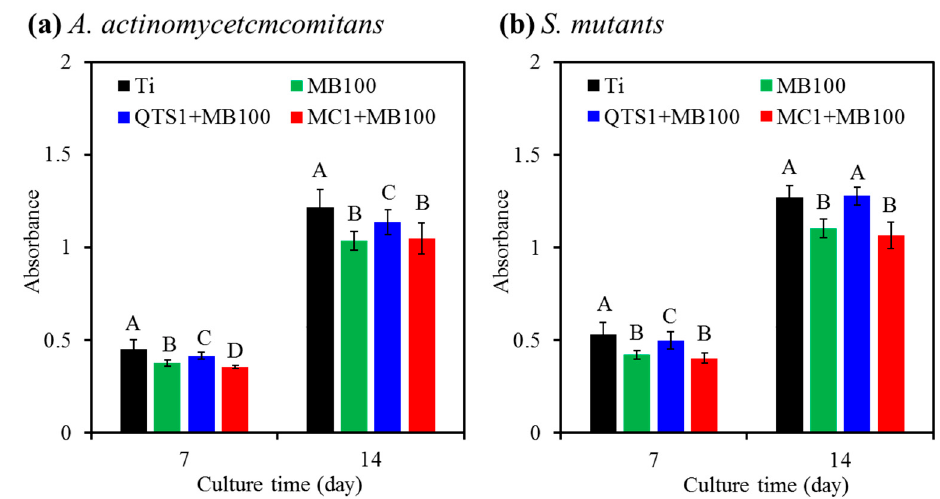
Figure 10. ALP activity of MG63 cells cultured on the surfaces after PACT (MB100, QTS1 + MB100 and MC1 + MB100) treated samples contaminated with ( a ) A. actinomycetcmcomitans and ( b ) S. mutants . The sterile Ti alloy was used as a control. Different capital letters showed statistically significant differences at p < 0.05 ( n = 5).